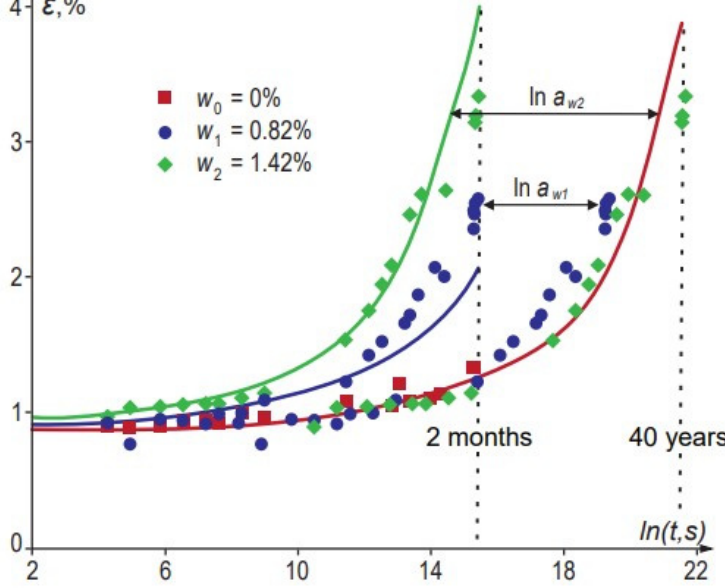
Figure 4. Creep curves of vinylester with different equilibrium moisture contents ( w 0 , w 1 , w 2 ) and the master curve constructed by applying TMSP. The Boltzmann–Volterra equation calculates the line for the linear viscoelastic solid and time–moisture shift function given by Equation (13). Data are taken from